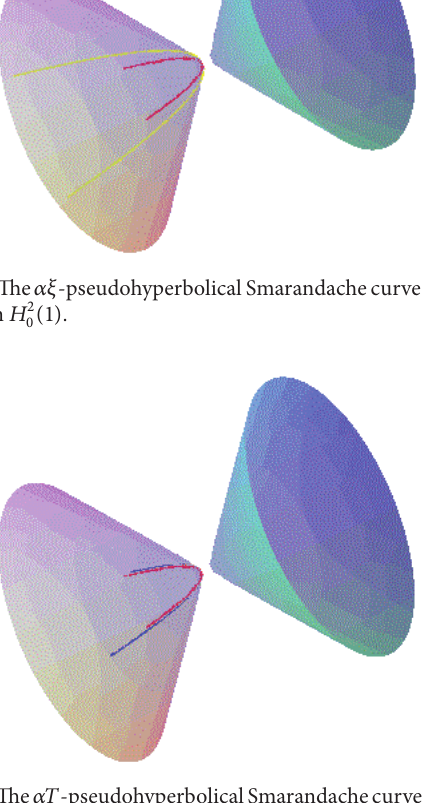
Figure3:The 𝛼𝑇 -pseudohyperbolicalSmarandachecurve 𝛽 andthe curve 𝛼 on 𝐻 2 0 (1) .